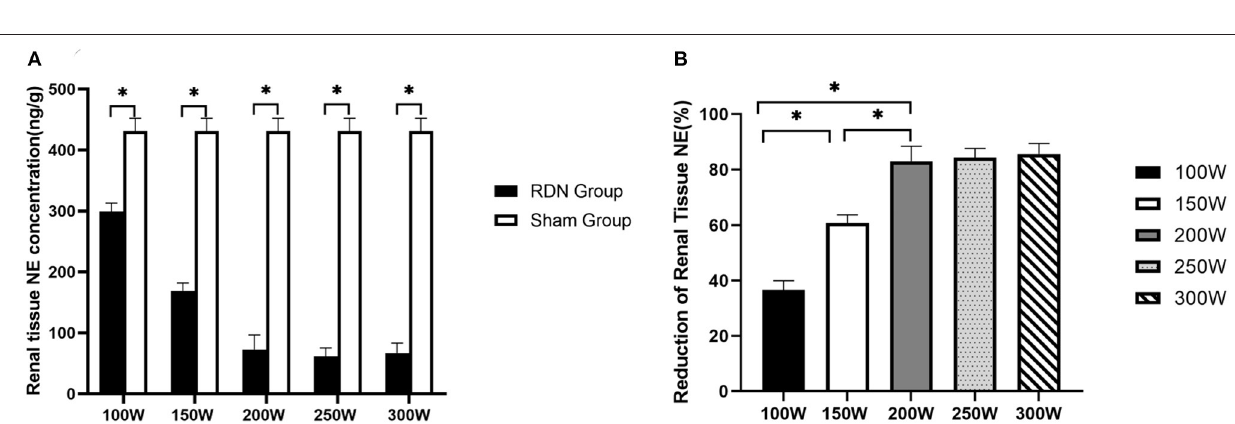
Figure 2 , BP reduction was greatest in the 300, 250, and 200 W groups ( − 15.17/ − 8.33 ± 1.47/1.21, − 14.67/ − 9.33 ± 1.21/1.37, and − 13.17/9.17 ± 2.32/1.84 mmHg, respectively) and showed no statistical differences (SBP: p = 0.513, DBP: p = 0.472), followed by the 150 W group ( − 6.67/ − 3.83 ± 1.03/1.47 mmHg), and the lowest reduction in BP was observed in the 100 W group, which showed no significant difference with the sham control